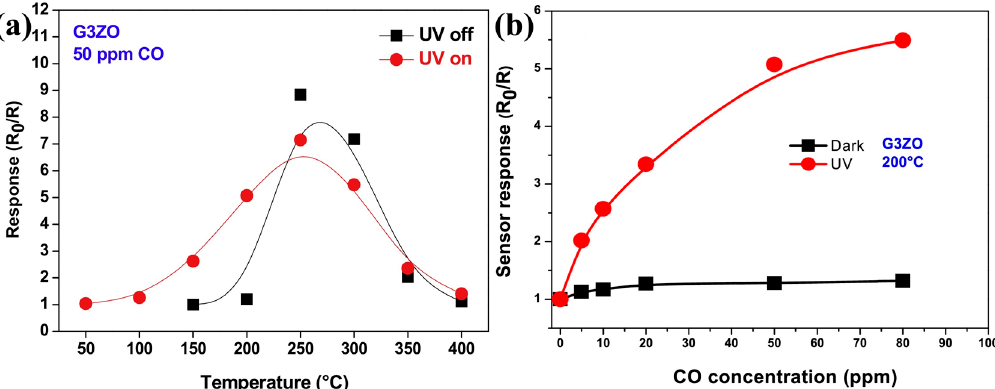
Figure 65. CO sensing response of the Ga doped ZnO (G3ZO) sensor with and without UV light irradiation ( a ) at different temperatures; ( b ) at 200 °C towards different concentrations. Reproduced with permission from [97].